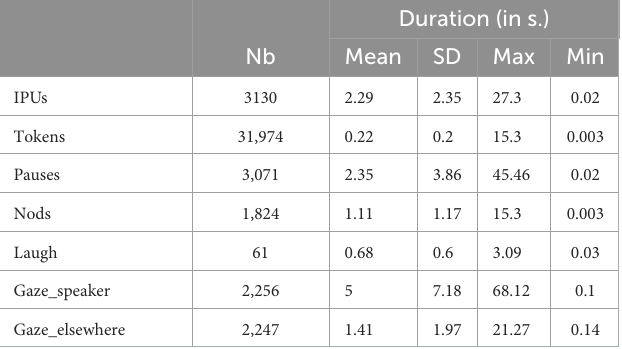
TABLE 1 Descriptive statistics on the annotations.